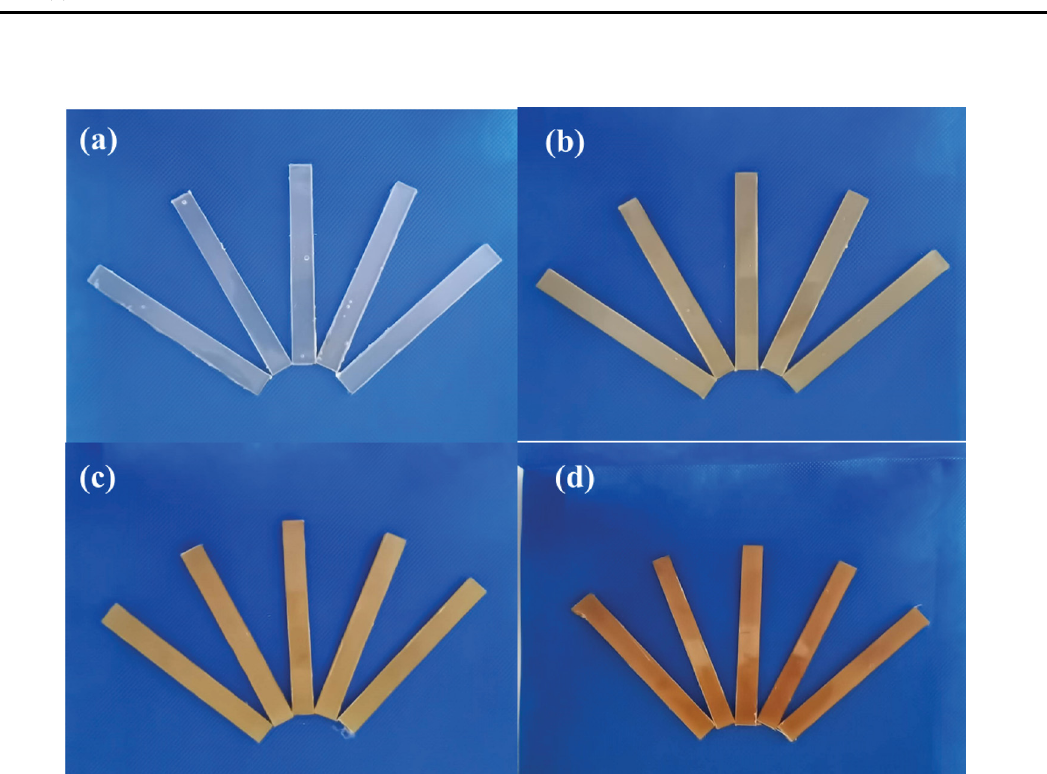
Figure A1: The sample of PLA/HCCP - EP composite for LOI test: ( a ) neat PLA, ( b ) PLA/HCCP - EP - 1, ( c ) PLA/HCCP - EP - 3, and ( d ) PLA/HCCP - EP - 5. The sample was produced according to the standard GB/T2406 -